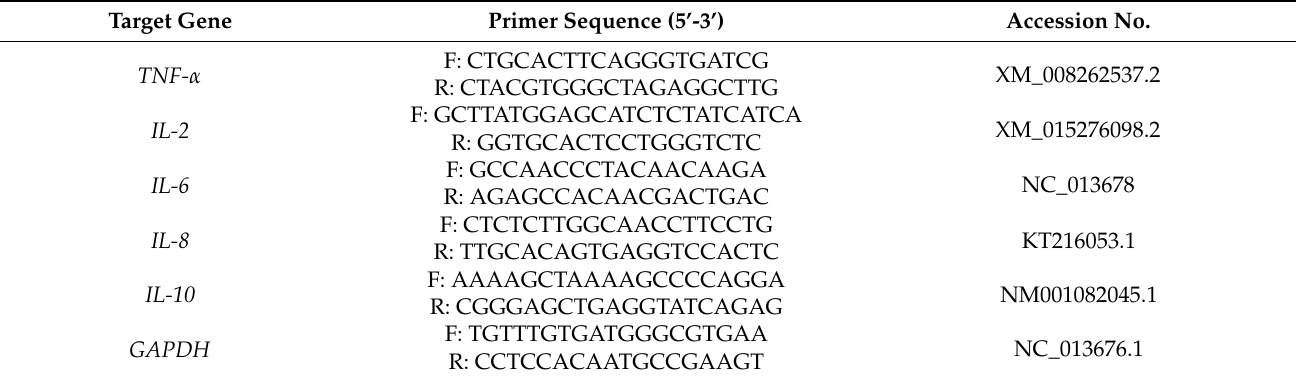
Table 3. Primer sequences of the cytokine-related genes used in the reverse transcription quantitative real-time PCR